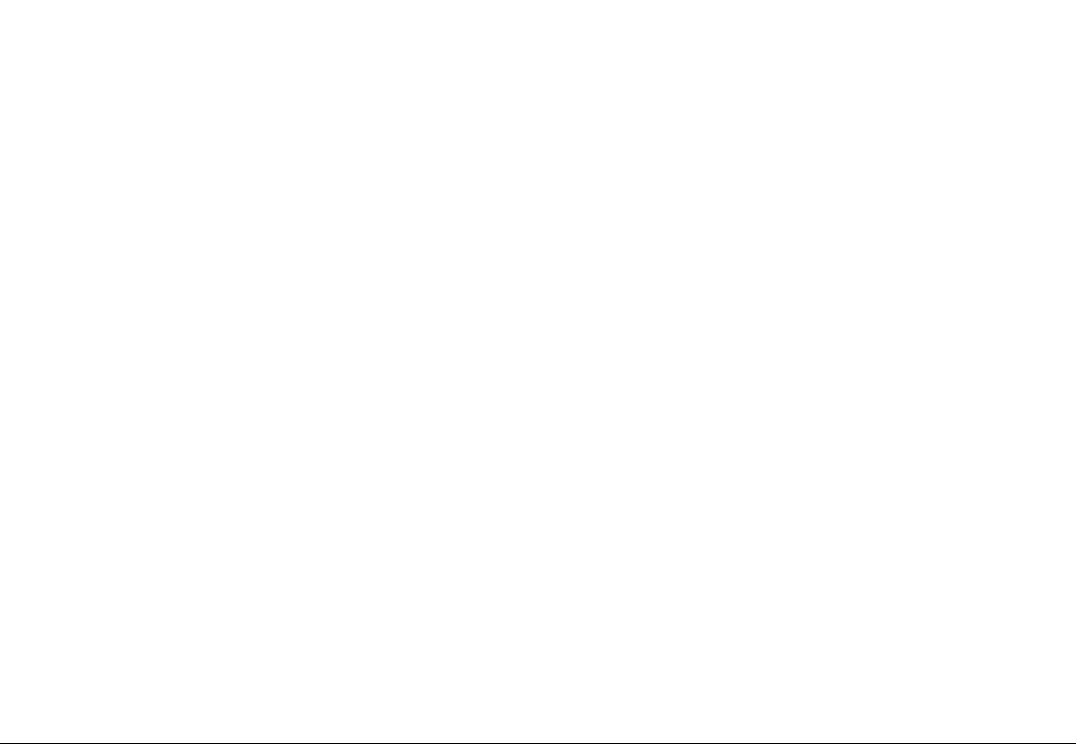
Table 2. Differences in the analyte distributions in controls and fibrotic or cirrhotic disease groups.